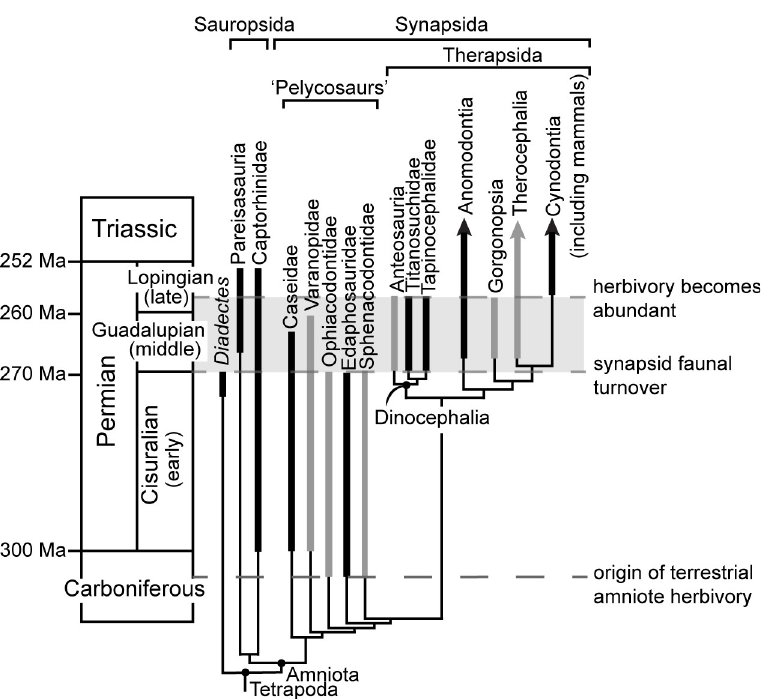
Fig 1. Simplified cladogram of Permian herbivores and major synapsid clades. The stratigraphic range of each taxon is represented by thick bars, with gray bar color characterizing carnivorous clades and black bar color signifying clades that include herbivorous taxa. The unique combination of trophic conditions (i.e. low abundance of terrestrial tetrapod herbivory and therapsid dominance) during the middle Permian is highlighted in gray.